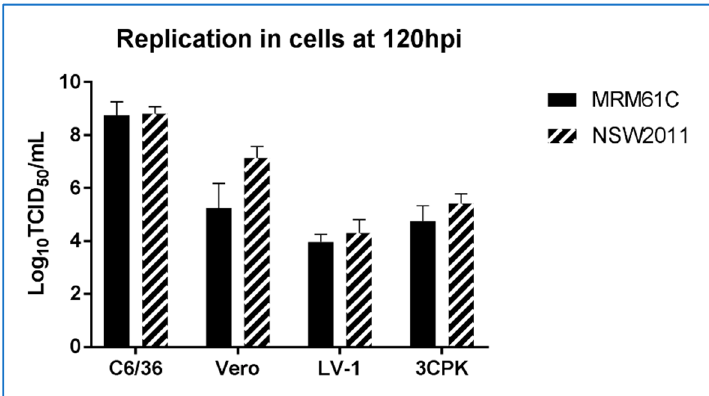
Figure 3. Comparison of virus replication in mosquito (C6/36), mammalian (Vero) and crocodile (1-LV, 3-CPK) cell lines.